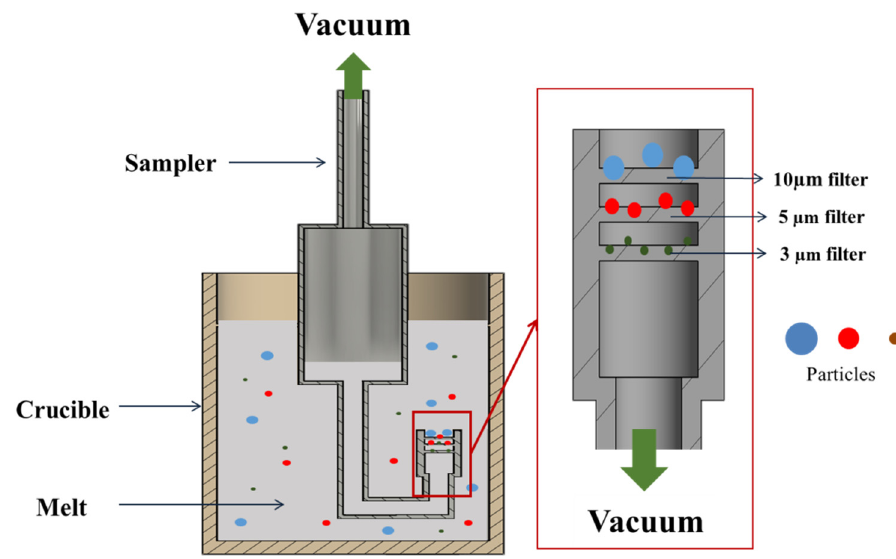
Figure 1. The schematic illustration of the vacuum-filtering experiment setup.